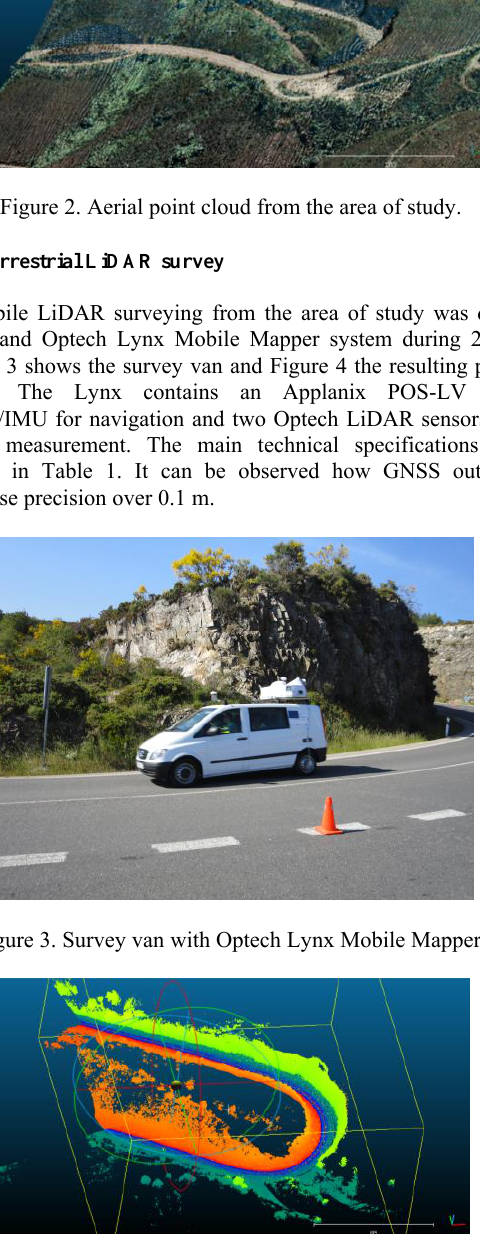
Figure 4. Point cloud obtained from the Mobile Terrestrial LiDAR